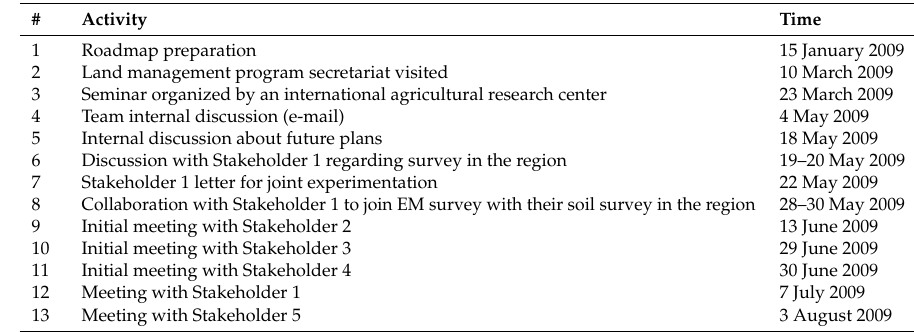
Table 1. Steps taken during